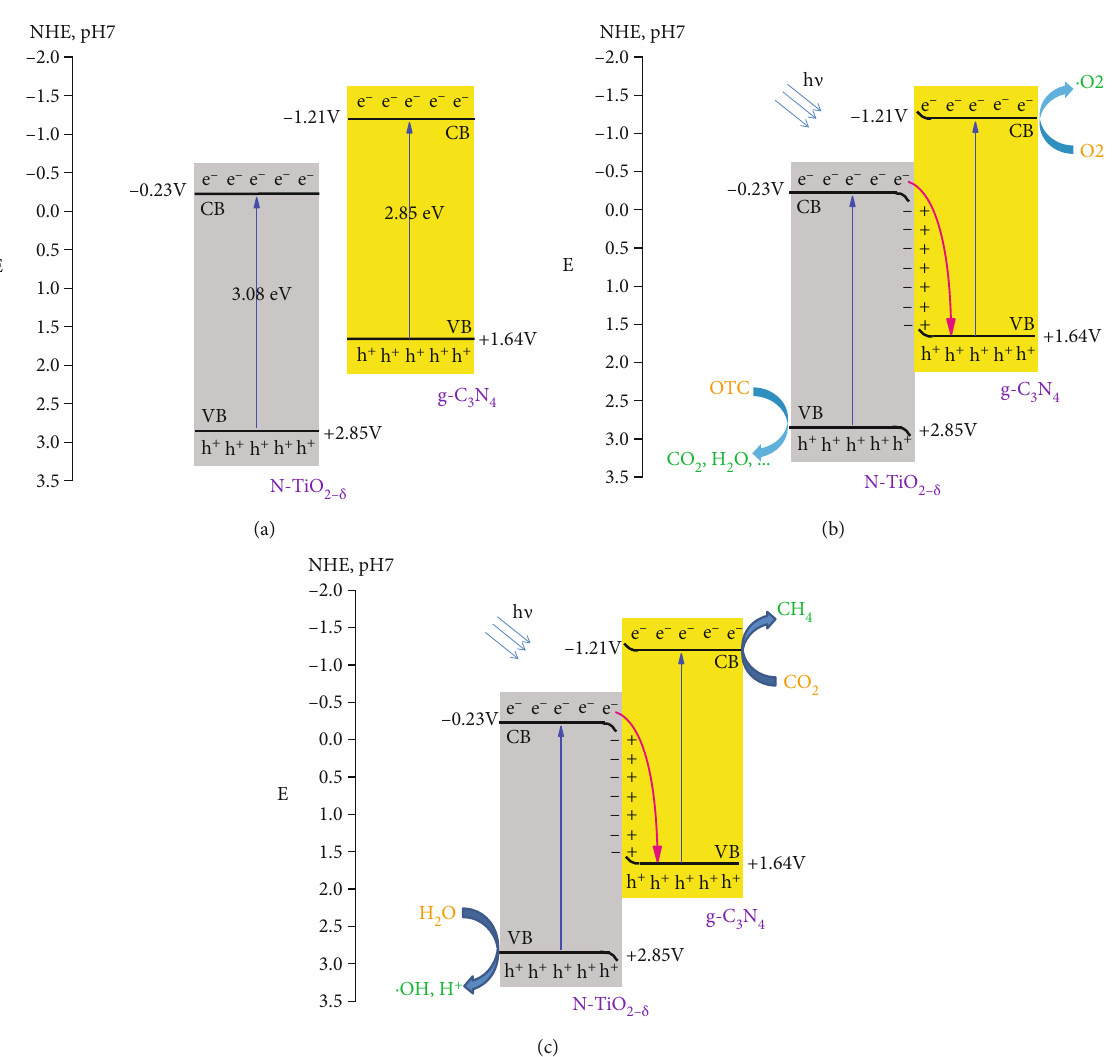
Figure 10: Schematic illustrations of the energy band structures of N-TiO heterojunction composite for OTC photooxidation mechanism (b), and CO